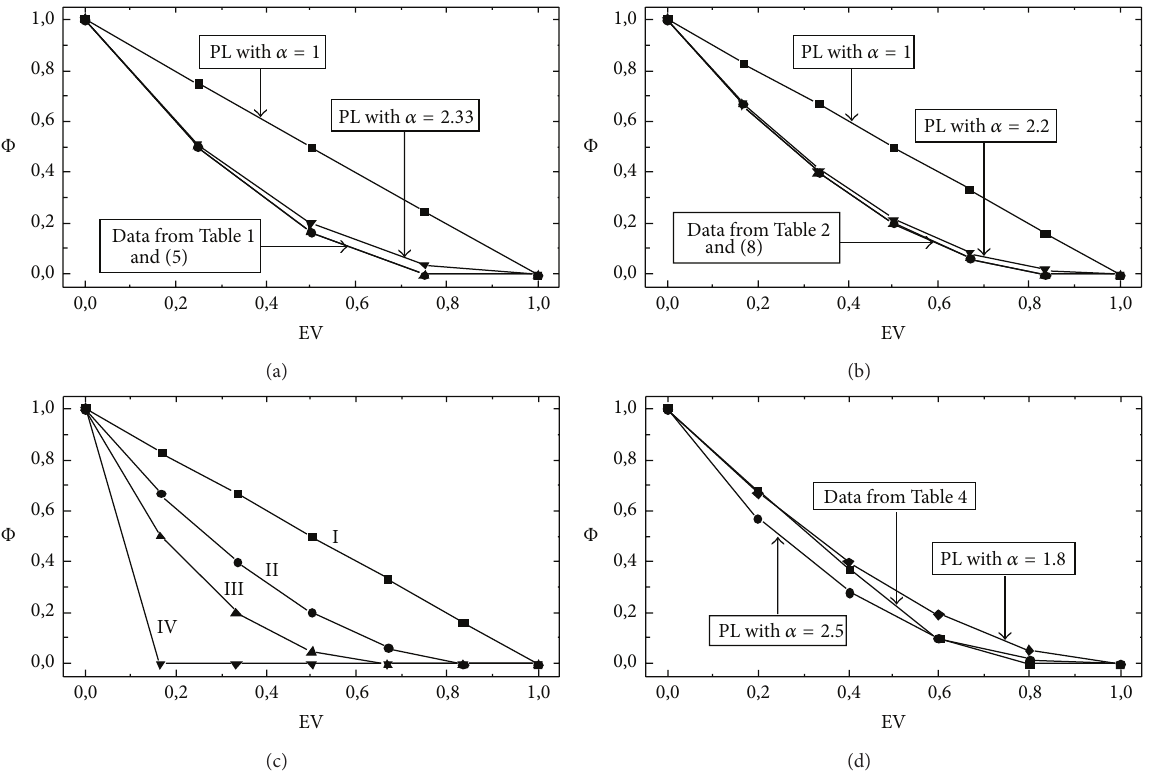
Figure 3: (a) and (b) Plots of the normalized diffusion coefficient ( B ) versus the excluded volume (EV) for the models of Figures 2(a) (a) and 2(b)(b1) (b). Figure 3(a) employs the direct data for B contained in Table 1; (3) with 𝛼 = 7/3 and 𝛼 = 1 ; and (5). Figure 3(b) employs the direct data for B contained in Table 2; (3) with 𝛼 = 11/5 and 𝛼 = 1 ; and (8). (c) Similar to (a) and (b), but for the reference model (I) and model (II) of Figure 2(b)(b1); the model of Figure 2(b)(b2) (III) and the model of Figure 2(c) (IV). (d) Similar to (c), but for the model of Figure 1(a), employing direct data from Table 4, and (3) with 𝛼 = 1.8 and 2.5. [ B = 𝛿 ∗ /𝛿 ∗ 0 , where 𝛿 ∗ is the average diffusion coefficient and 𝛿